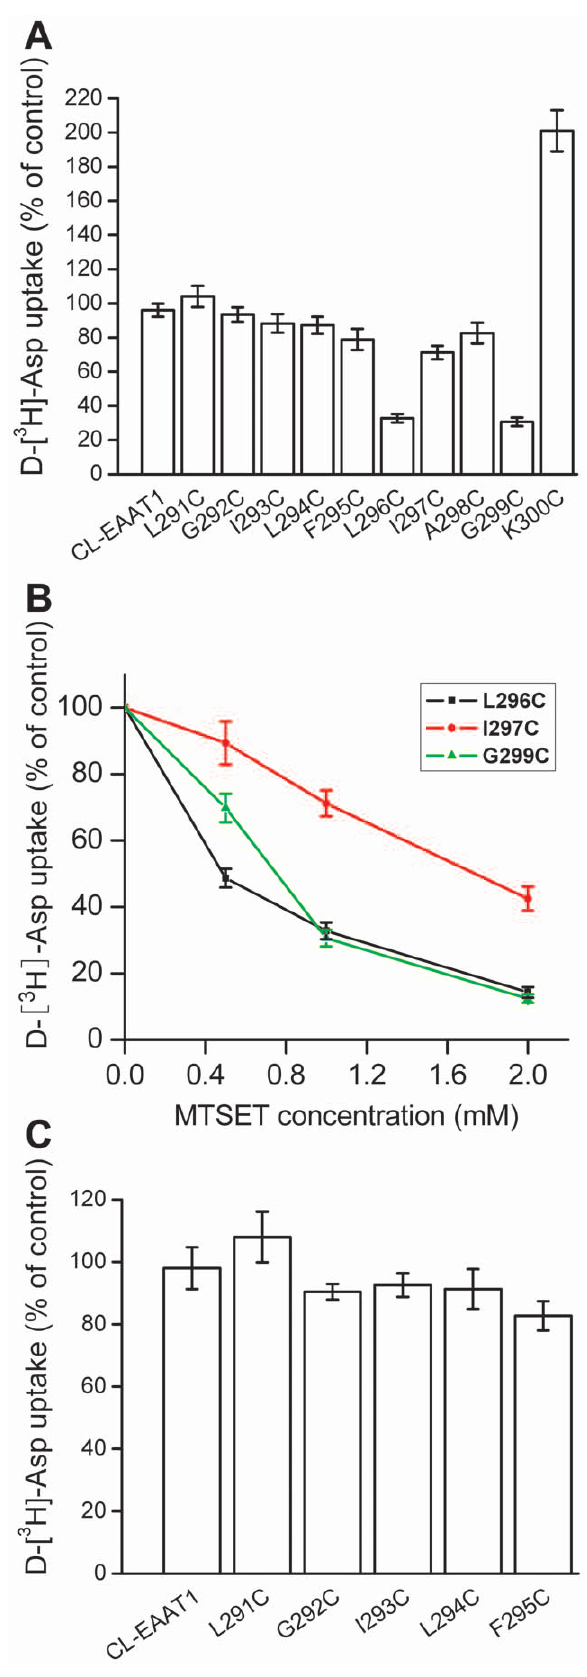
Figure 3. Effect of MTSET and MTSEA on uptake activity of single cysteine mutants of TM5. HeLa cells expressing single cysteine mutants or Cysteine-less EAAT1, were preincubated in NaCl- containing medium with sulfhydryl reagent for 5 min at room temperature, washed twice with choline chloride-containing solution, and subsequently D-[ 3 H]-aspartate transport was assayed. Data represent percentage of the remaining uptake activity after incubation with sulfhydryl reagent relative to values obtained in the absence of sulfhydryl reagent. Values represent the mean 6 S.E. of at least three separate experiments each performed in triplicate. ( A ) Effect of MTSET on transport activity of single cysteine mutants of TM5. The concentration of MTSET used in this study was 1.0 mM. ( B ) Effect of different concentrations of MTSET on transport activity of L296C, I297C and G299C. ( C ) Effect of MTSEA on transport activity of single cysteine mutants of TM5. The concentration of MTSEA used in this study was 2.5